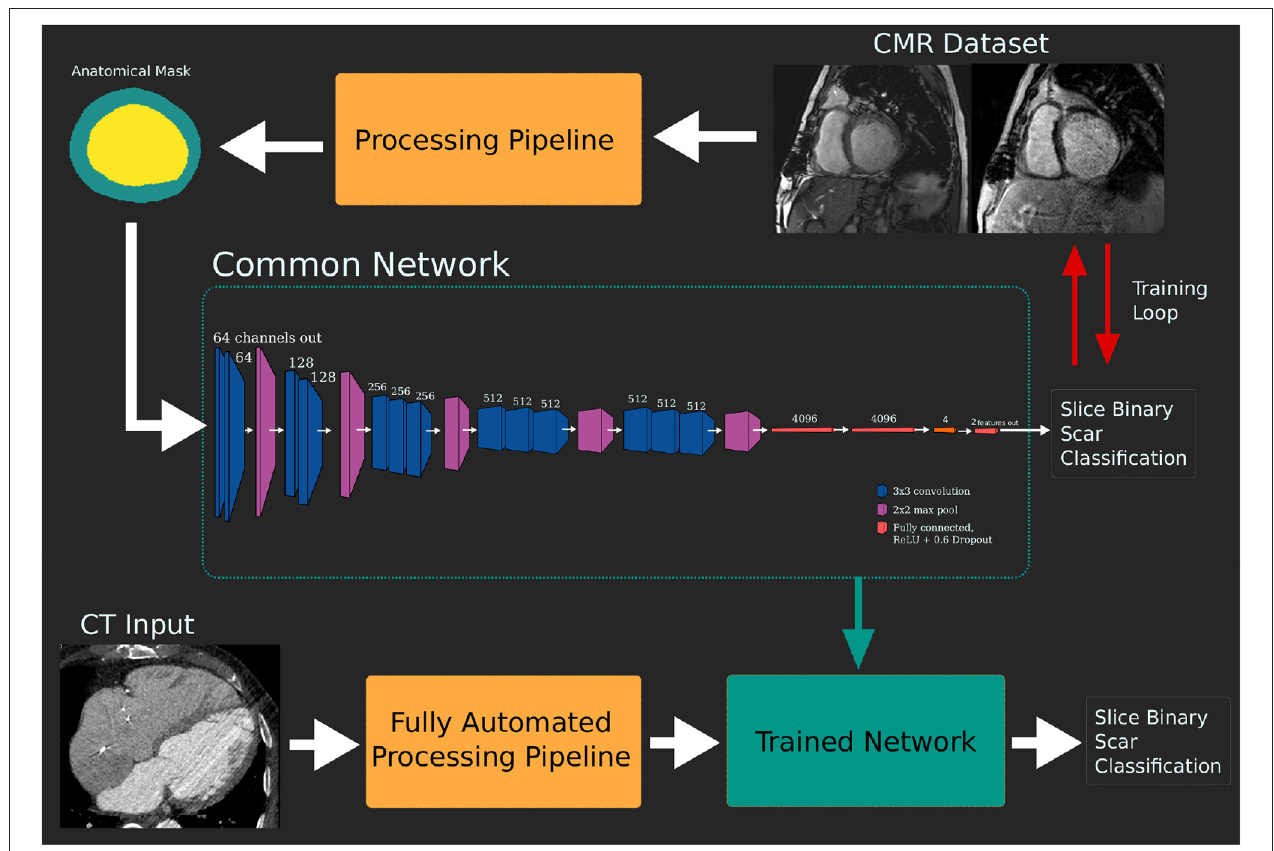
FIGURE 3 | Pipeline of model training and testing. The network is trained using the dataset derived from the gold standard late gadolinium enhancement (LGE) magnetic resonance imaging (MRI) dataset. This trained network can then be tested against the target modality dataset without additional